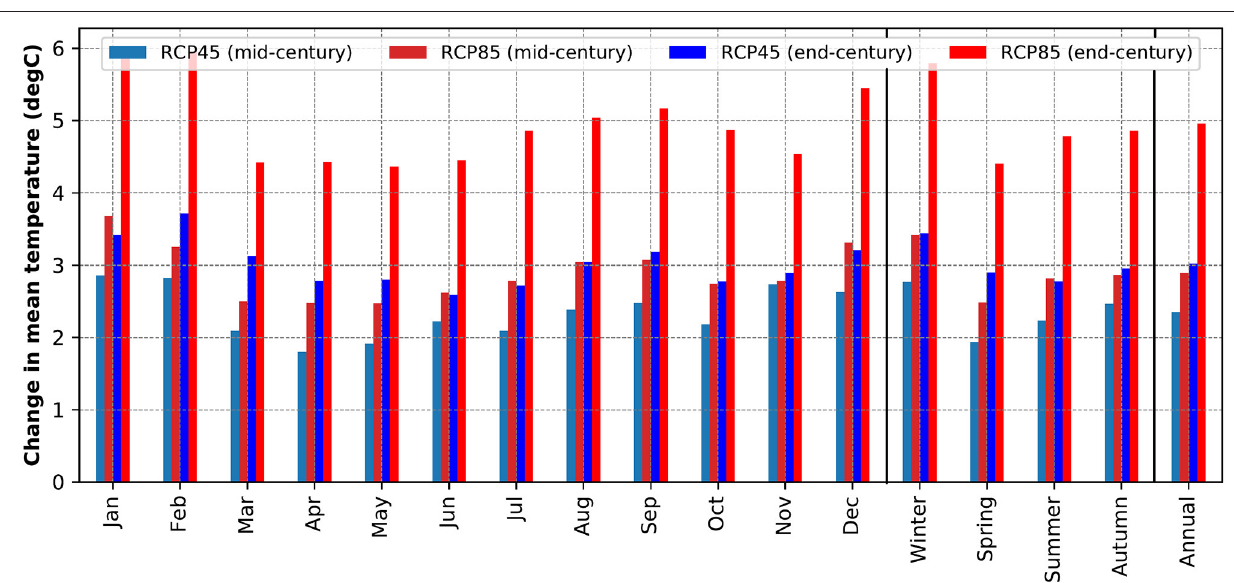
Frontiers in Water |